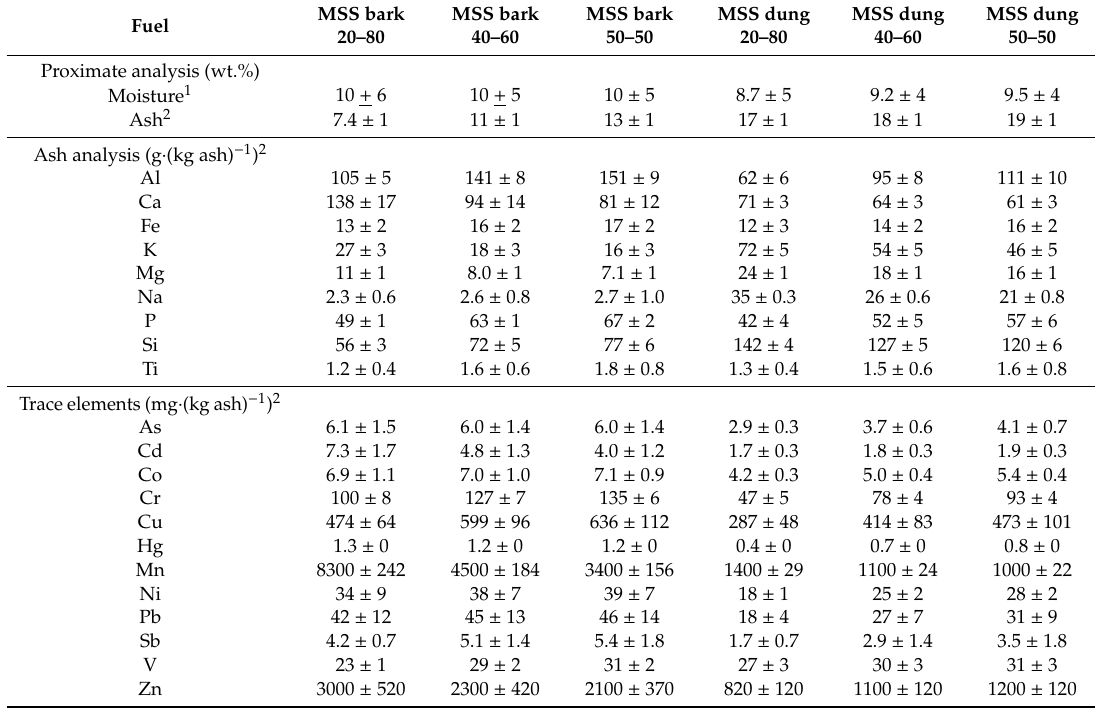
Table 2. Calculated properties of the fuel mixtures used in the lab experiments, based on the measured data given in Table